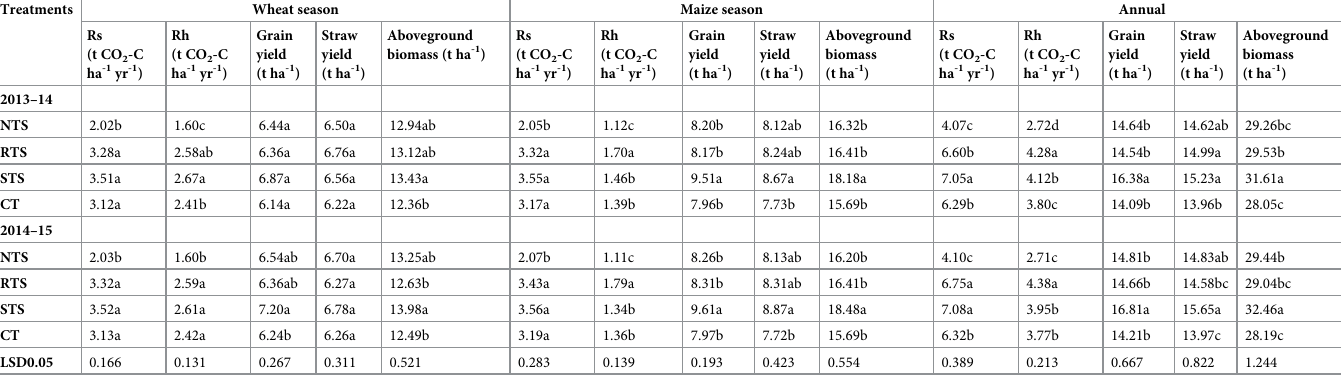
Table 2. Total soil respiration (R s ), microbial respiration (R h ), and wheat and maize grain yields, straw yields and aboveground biomass during the wheat- and maize- growing seasons during the 2013–2015 rotation. Treatments